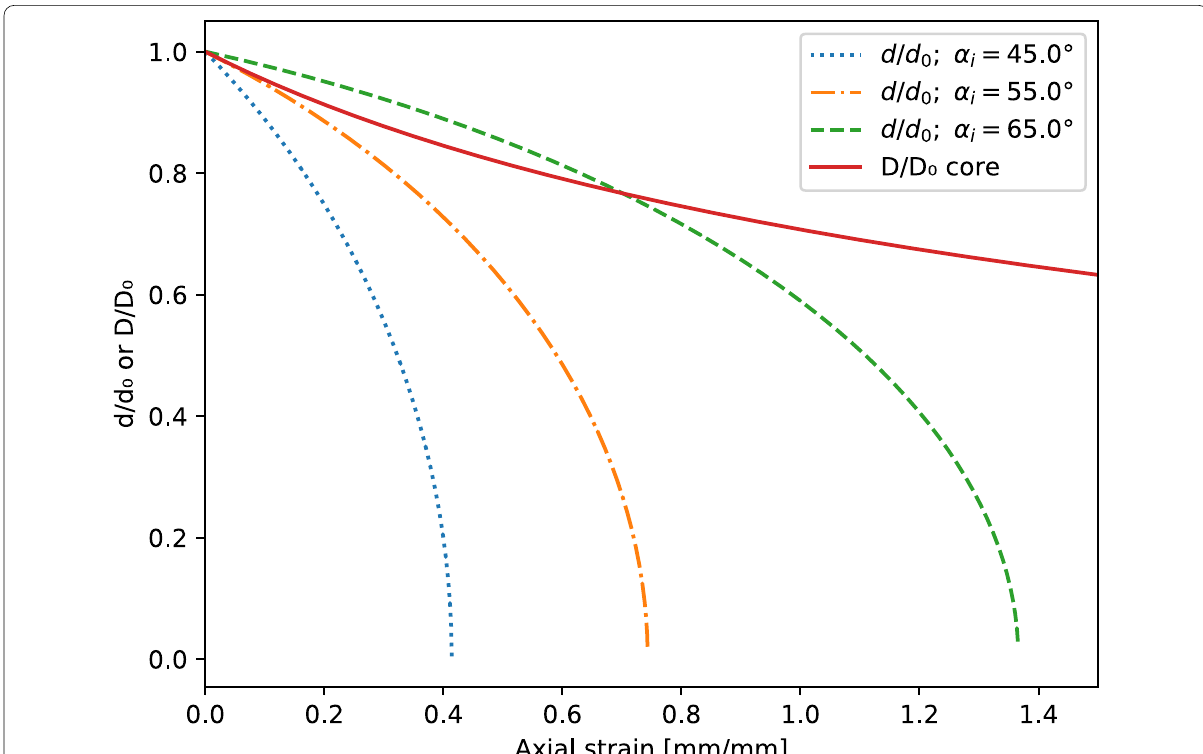
Fig. 2 Variation of core diameter and braid diameter with different initial braiding angles as a function of axial